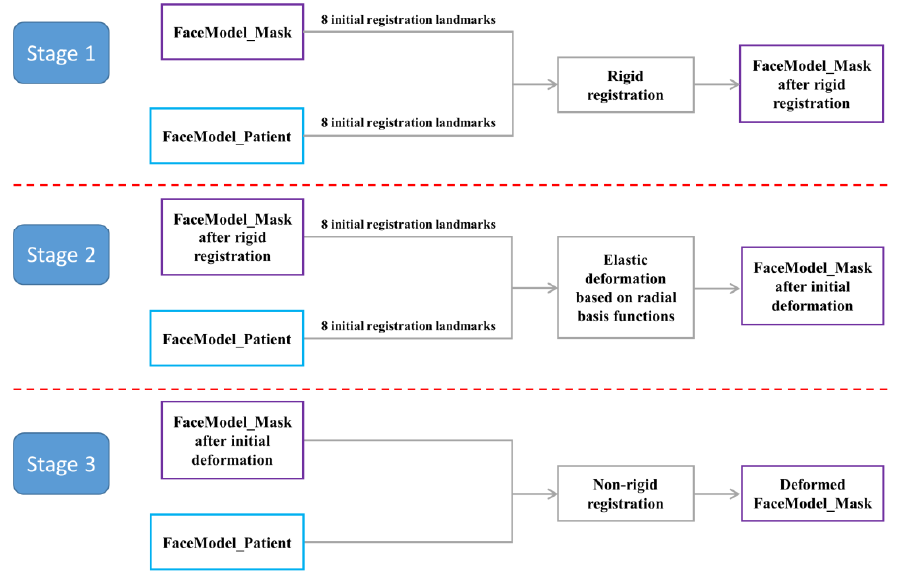
Figure 4. Flow chart of the TH-OCR algorithm.